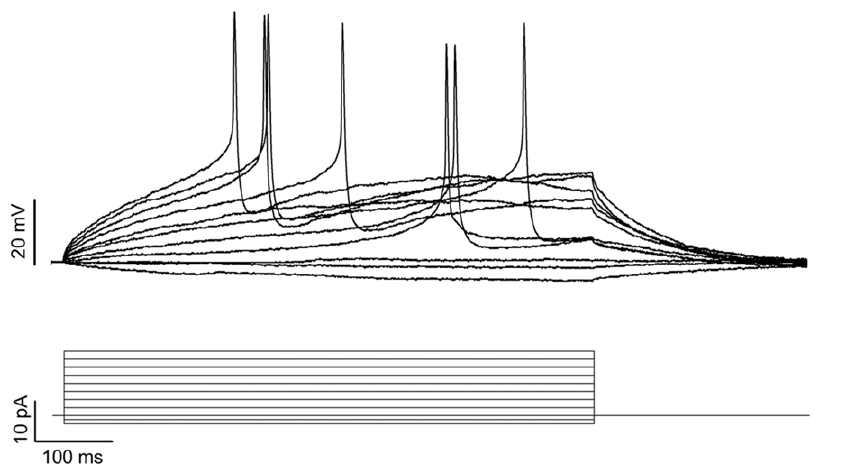
Figure 4. Neurons derived from iPS cells support action potentials. Whole-cell patch-clamp recordings were made in current-clamp mode from the soma of neurons. Shown above are representative traces recorded from one neuron that generated action potentials in response to depolarization. The stimulus protocol is depicted in lower traces. Membrane potentials were recorded from four neurons.